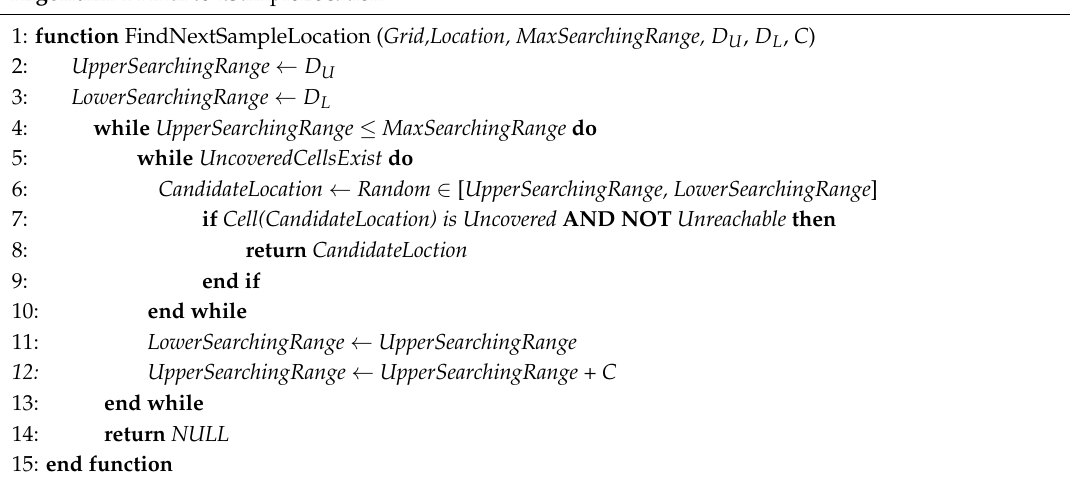
Algorithm 1 FindNextSampleLocation